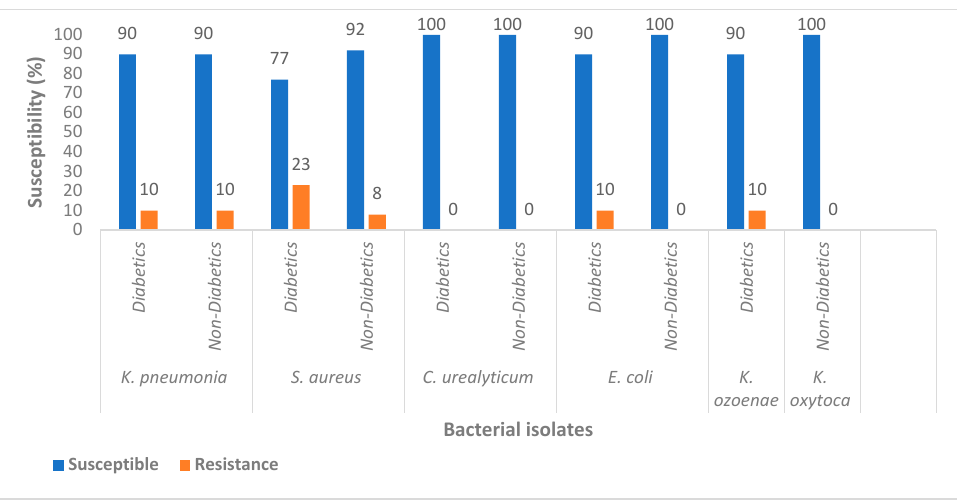
Figure 1. Overall susceptibility of bacterial isolates. E. coli : Escherichia coli , S. aureus : Staphylococcus aureus , K. pneumoniae : Klebsiella pneumoniae , K. oxytoca : Klebsiella oxytoca , K. ozoenae : Klebsiella ozoenae , C. urealyticum : Corynebacterium urealyticum . Using E. coli as a dominant isolate, it was observed that there were no significant differences ( p -values greater that 0.05) in susceptibility patterns among diabetics and non- diabetic individuals (Table 5). Table 5. Susceptibility pattern of E. coli isolates from diabetic and non-diabetic individuals with UTI to different antibiotics . Antibiotics